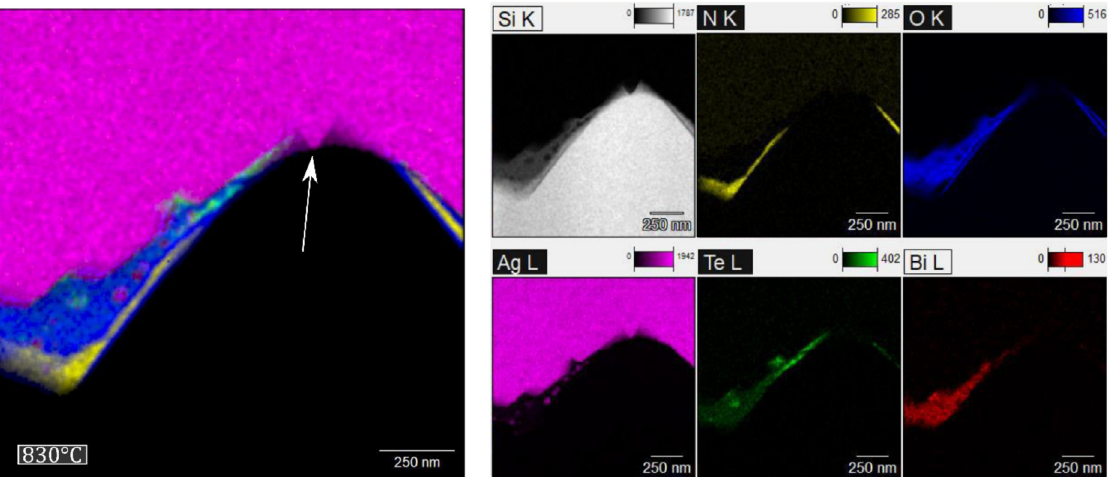
Fig. 7. EDX mapping for a cross section of a Si pyramid with Ag crystallite at the top, combined on the left, for each element respectively on the right. This is an example of a direct contact.